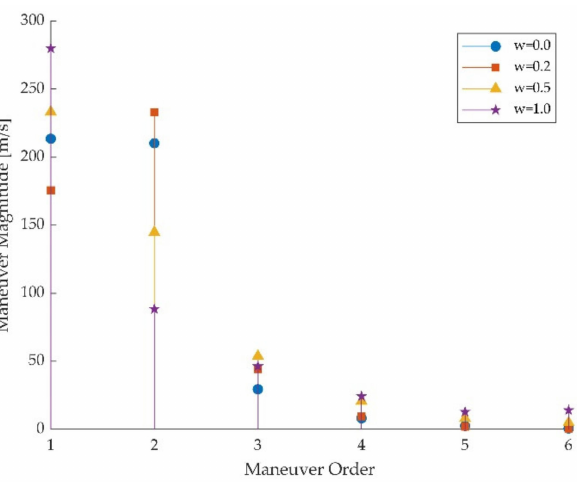
Figure 5. Distributions of the magnitude of dv s along the optimal trajectories with different w